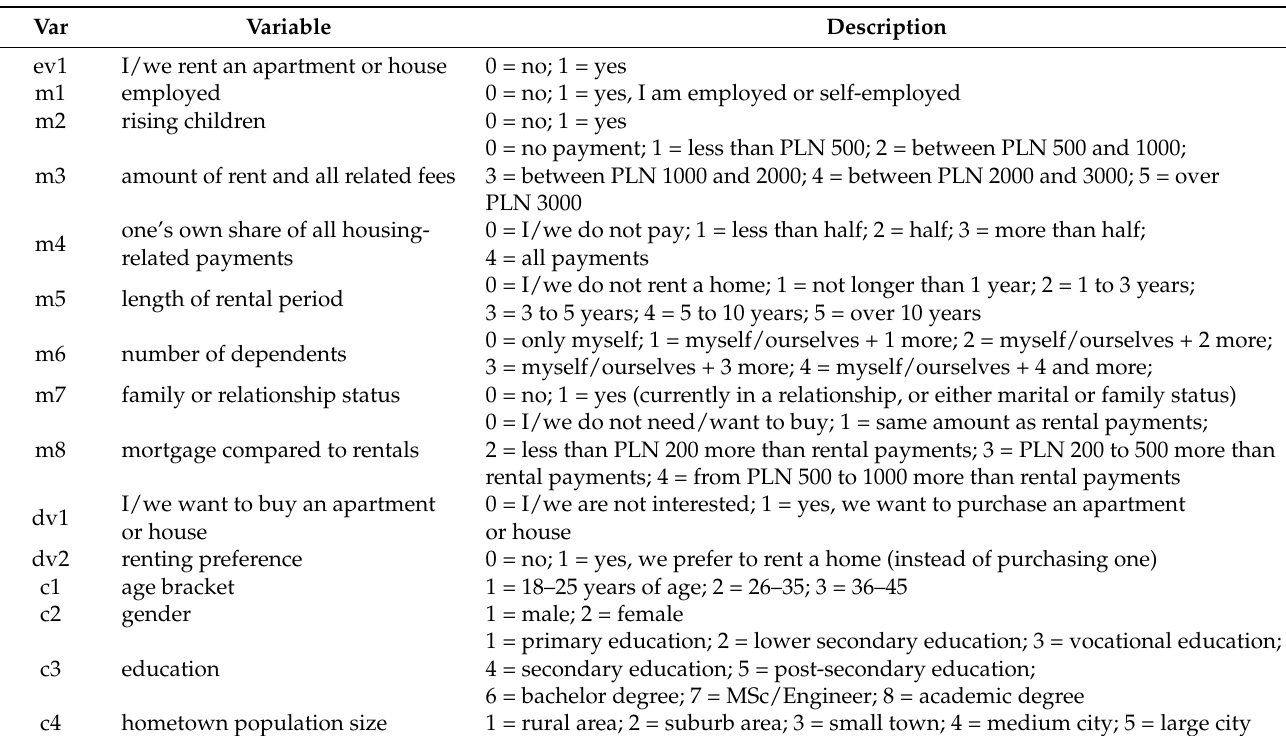
Table 1. Questionnaire questions and the observable variables behind them.